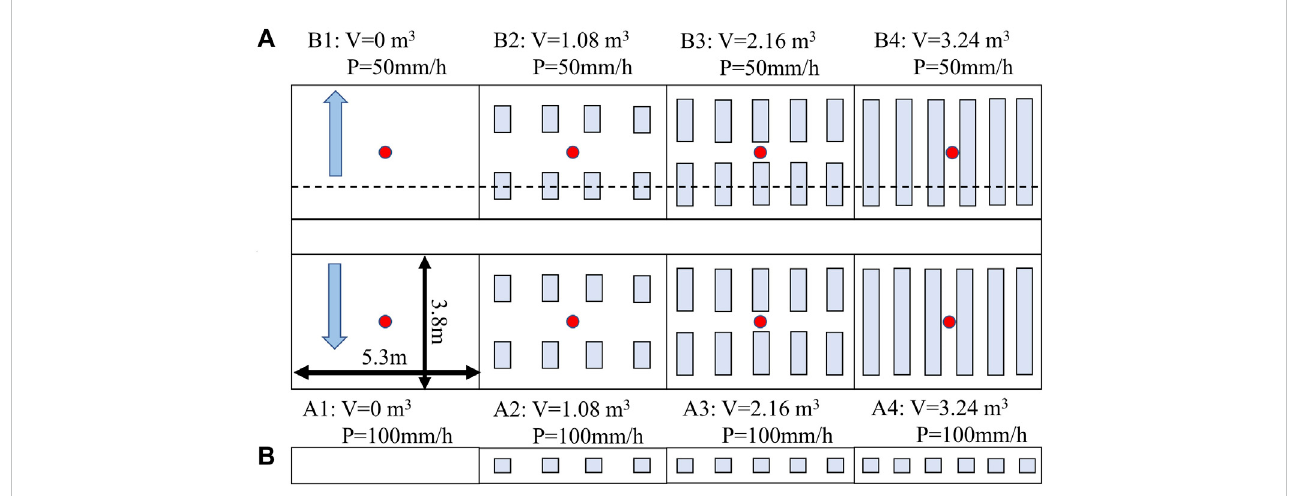
FIGURE 2 Picture (A) and (B) represent the plane and sectional fi gure of RW embedding, respectively. Red circles indicate soil moisture sensors in the center of every experiment plot, A1 – A4 and B1 – B4 represent the number of the experimental groups, V represents the volume of RW embedding in the soil, P represents the rainfall intensity.